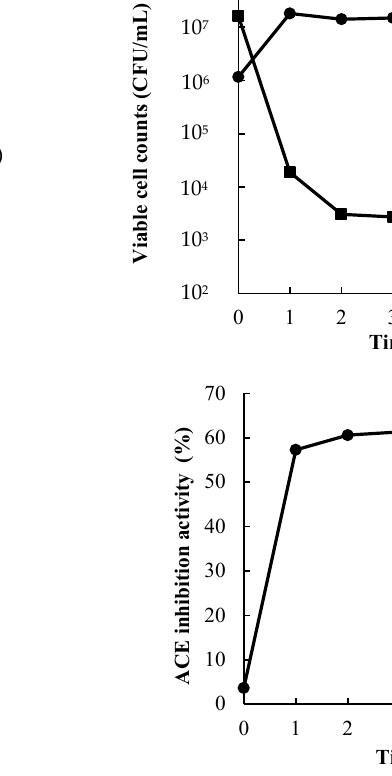
Figure 1. Viable cell counts ( ● ) and pH ( ■ ) of L. pentosus SN001 fermented S. horneri ( A ), ACE inhibition activity (final concentration: 0.83 mg/mL) ( B ) The data represented the mean values ± standard error ( n = 4) .